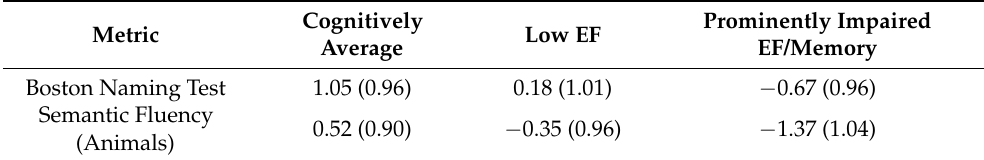
Table A3. Z -scores of Language Metrics across